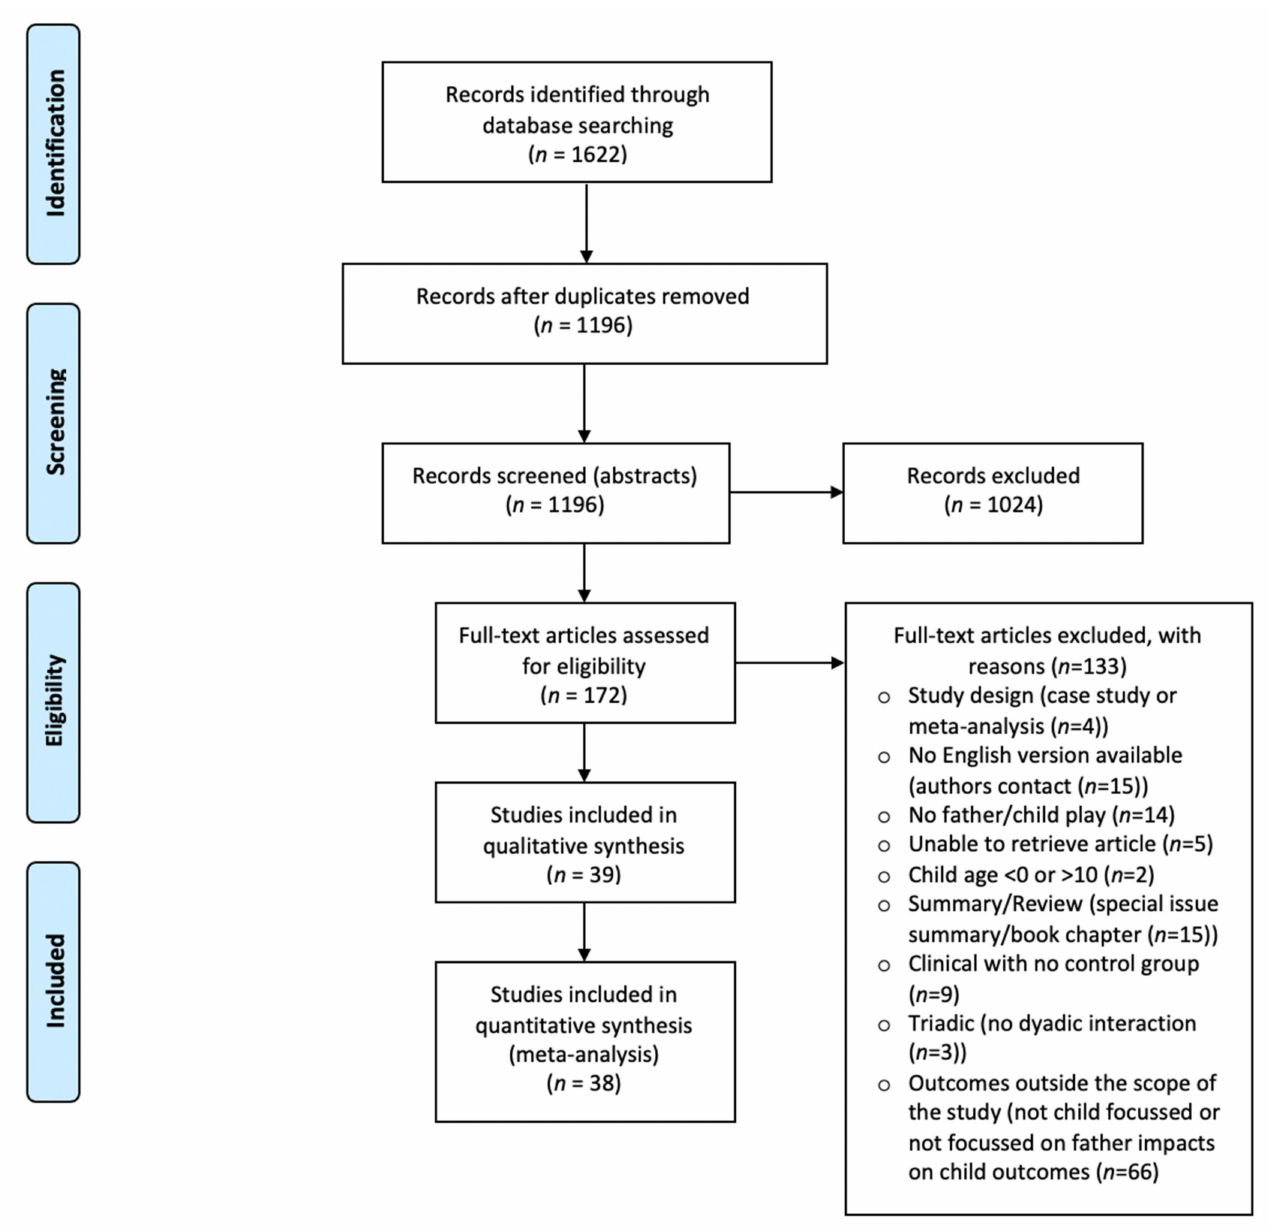
Figure 1. PRISMA flowchart outlining the selection process for the systematic